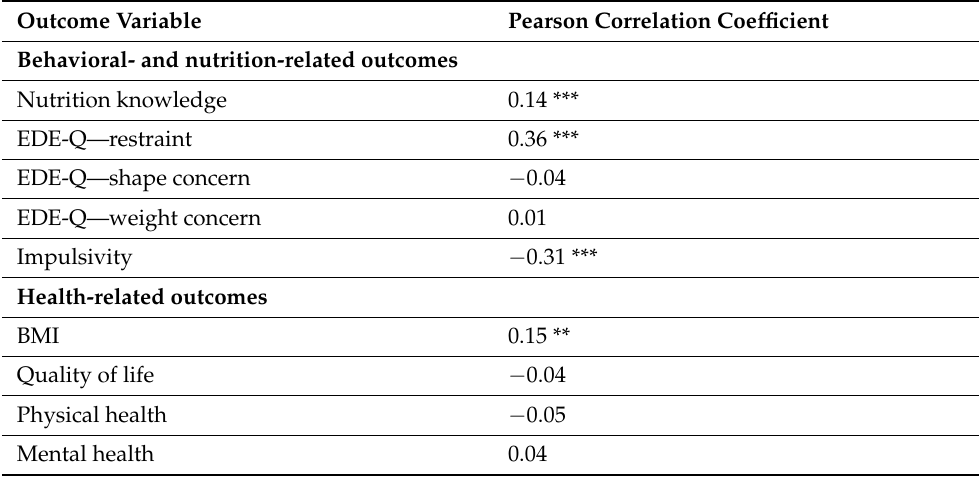
Table 4. Interrelations between the GDBI score and outcome variables.